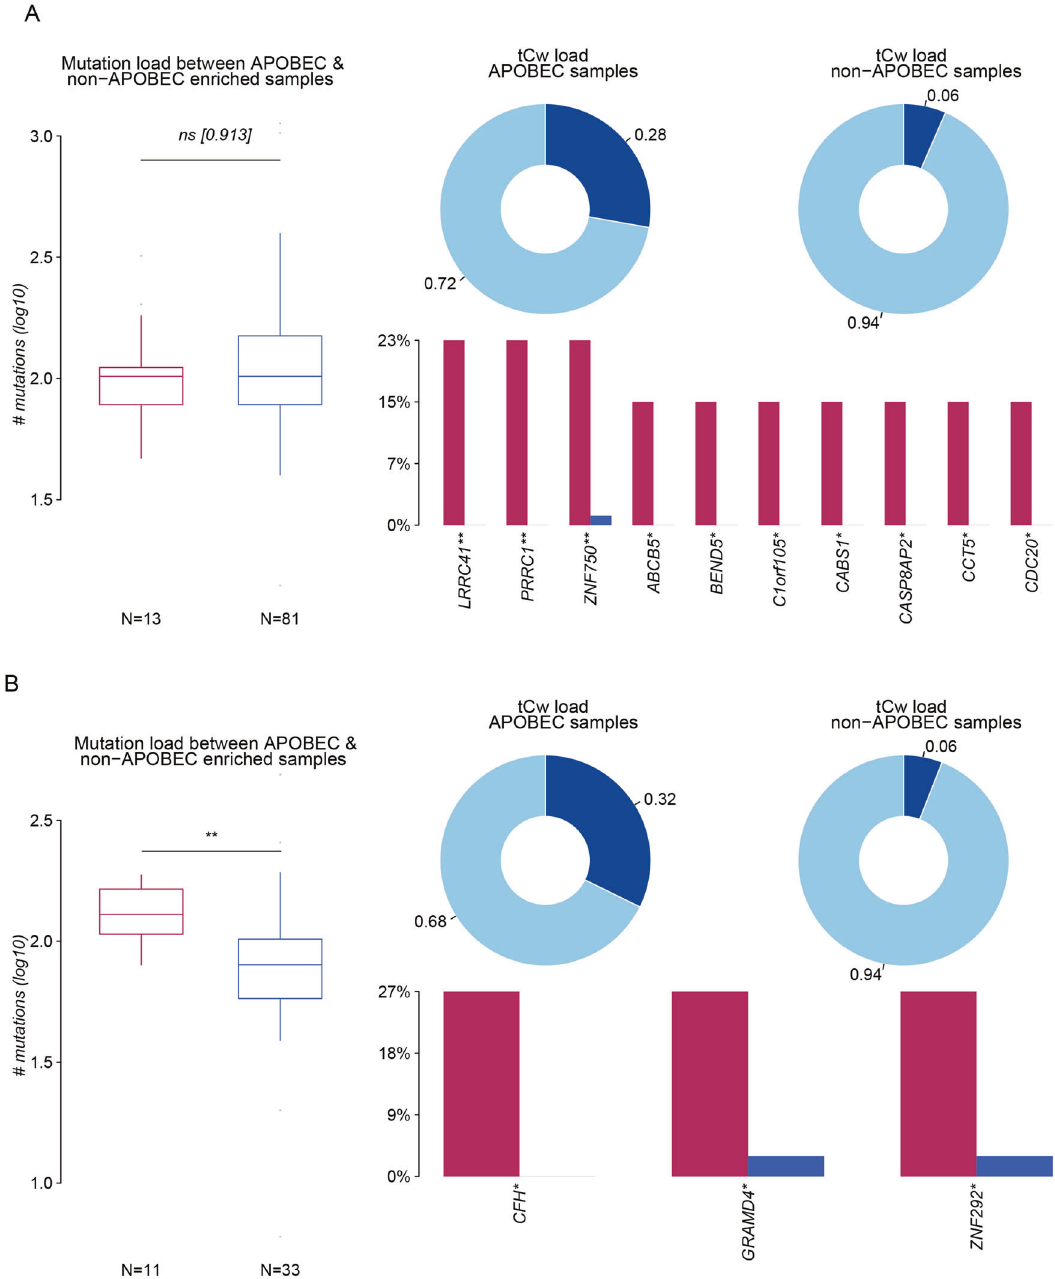
Fig. 7 APOBEC family mutation landscape in two CRGs -score groups. A The mutation load and tCw load between the APOBEC and non- APOBEC enriched samples in the high-CRGs score group. B The mutation load and tCw load between the APOBEC and non-APOBEC enriched samples in the low-CRGs score group. Data was exhibited as mean ± SD. Signi fi cance were assessed by Wilcoxon test ( A , B ). ns = not signi fi cant, * P < 0.05; ** P < 0.01; *** P <